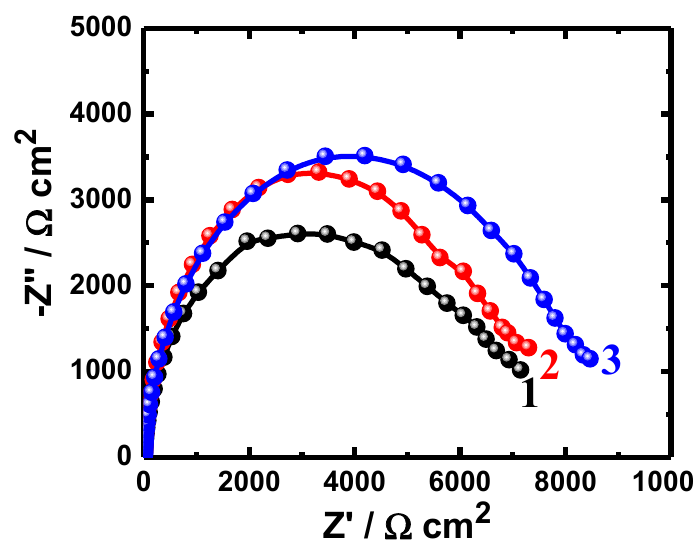
Figure 2. Nyquist plots obtained for (1) PS, (2) PSC1, and (3) PSC2 after their immersion in 4% NaCl solution for 24 h.